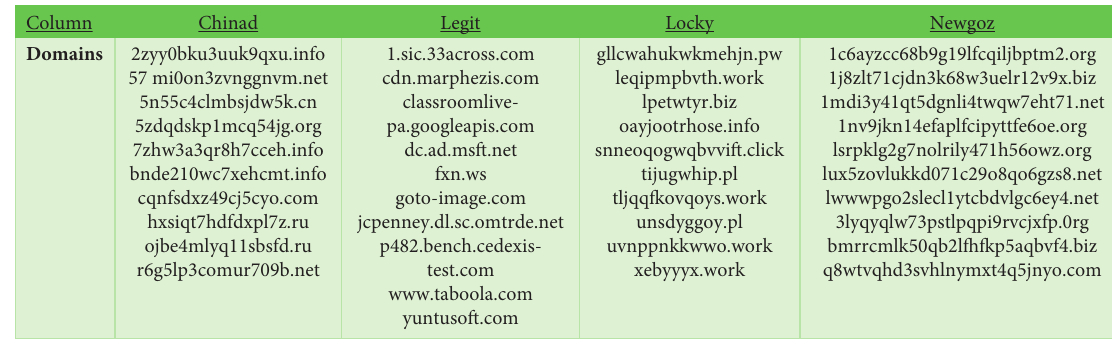
Figure 1: Separation of domains by DGA botnet.